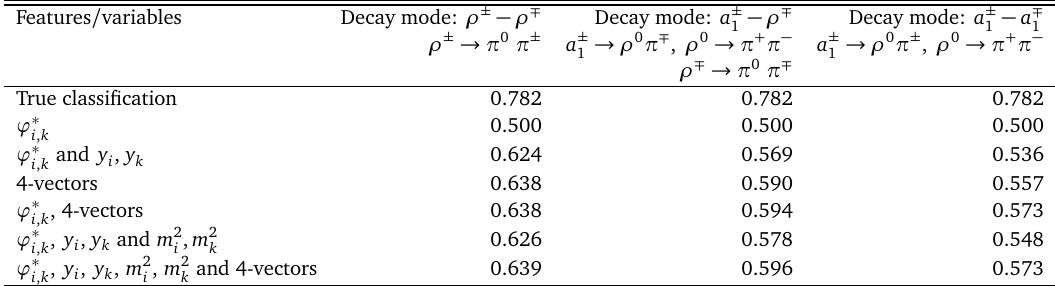
Table 1: Average probability p (calculated as explained in Ref. [ 20 ] ) that a model i predicts correctly event x to be of a type A (scalar), with training being performed i for separation between type A and B (pseudo-scalar). Different sets of variables were used as an input. The ϕ ∗ , y , y can be understood as approaches to construct i k i , k expert variables, but as we could observe, their use did not brought improvements with respect to the case when 4-vectors of the τ decay products were used alone, provided proper reference frame was used. Results taken from Ref. [ 20 ] .